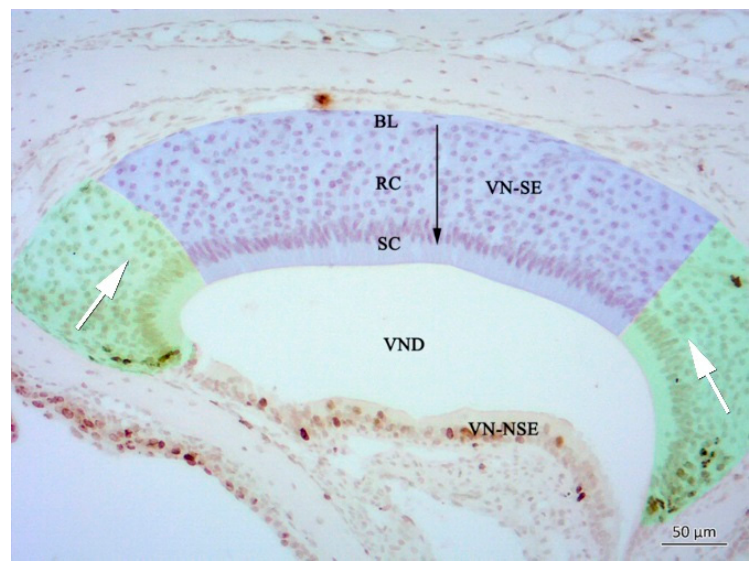
Figure 2. Frontal section of the vomeronasal organ displaying two distinct proliferation zones. Cells of the marginal compartments (green) migrate horizontally (white arrows); cells of the central compartment (blue) migrate vertically (black arrow) thereby following a basal-apical migration route. BL: Basal lamina; RC: nuclei of vomeronasal receptor cells; SC: layer of supporting cells; VN-SE: vomeronasal sensory epithelium, VN-NSE: vomeronasal non-sensory epithelium; VND: vomeronasal duct.